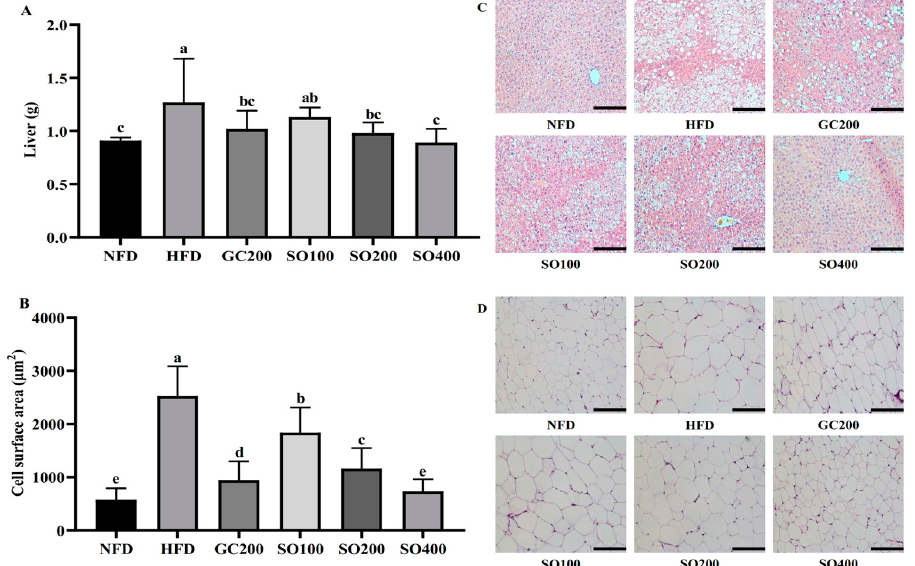
Figure 6. Effects of SO on hepatic steatosis and adipocyte hypertrophy in HFD-induced obese mice: ( A ) liver weight; ( B ) quantification of adipocyte area in white adipose tissue; ( C ) H&E staining of the liver; and ( D ) H&E staining of white adipose tissue. GC200, HFD supplemented with 200 mg/kg/day of GC; SO100, HFD supplemented with 100 mg/kg/day of SO; SO200, HFD supplemented with 200 mg/kg/day of SO; SO400, HFD supplemented with 400 mg/kg/day of SO. The scale bar represents a length of 50 µ m. Values are expressed as mean ± SD of experiments. Different letters indicate significant differences at the level of p < 0.05.